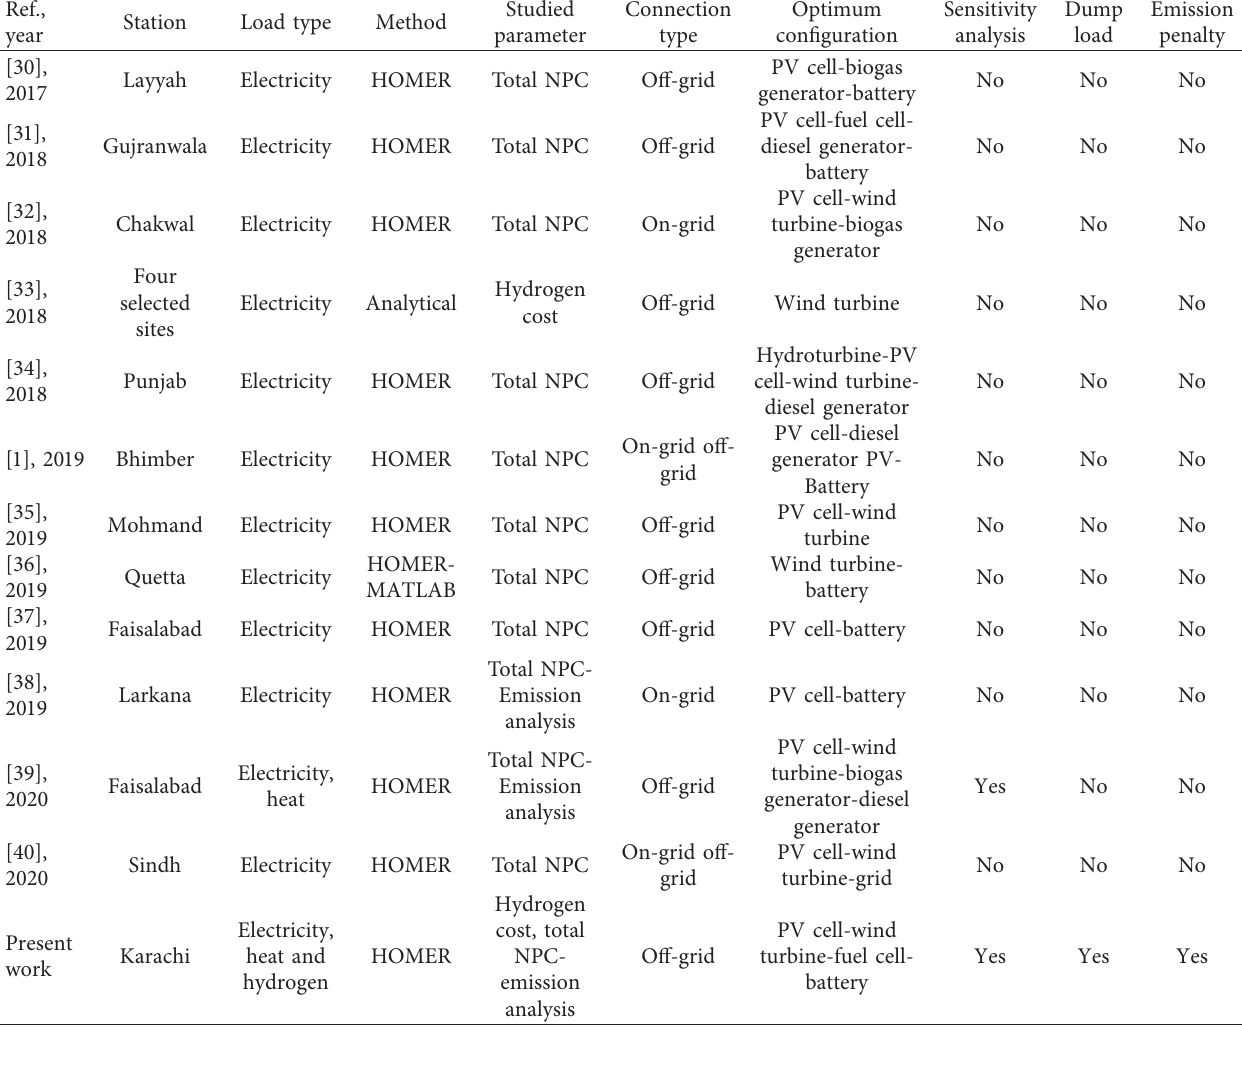
Table 1: Recent studies on renewable energies in Pakistan.